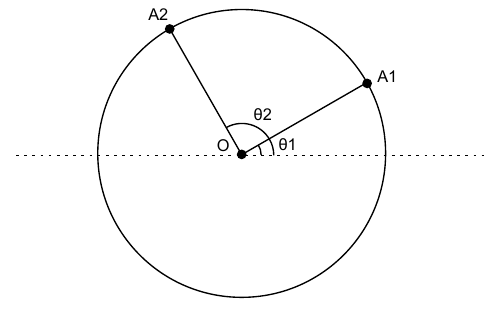
Figure 9. A topology where source and destination nodes are on the same circle.